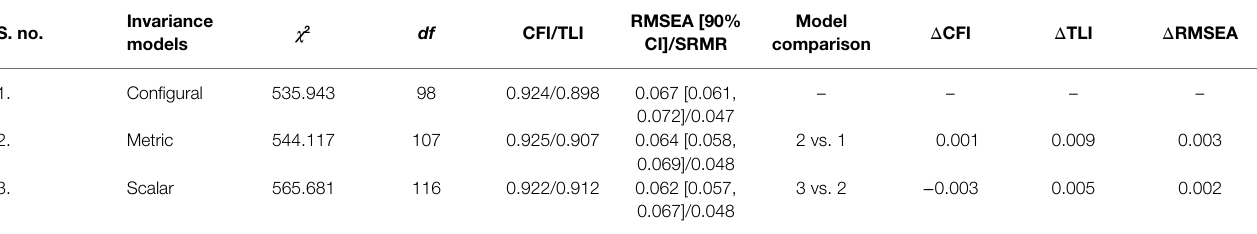
TABLE 6 | Summary of the goodness-of-fit indexes of the tests of gender invariance. S.